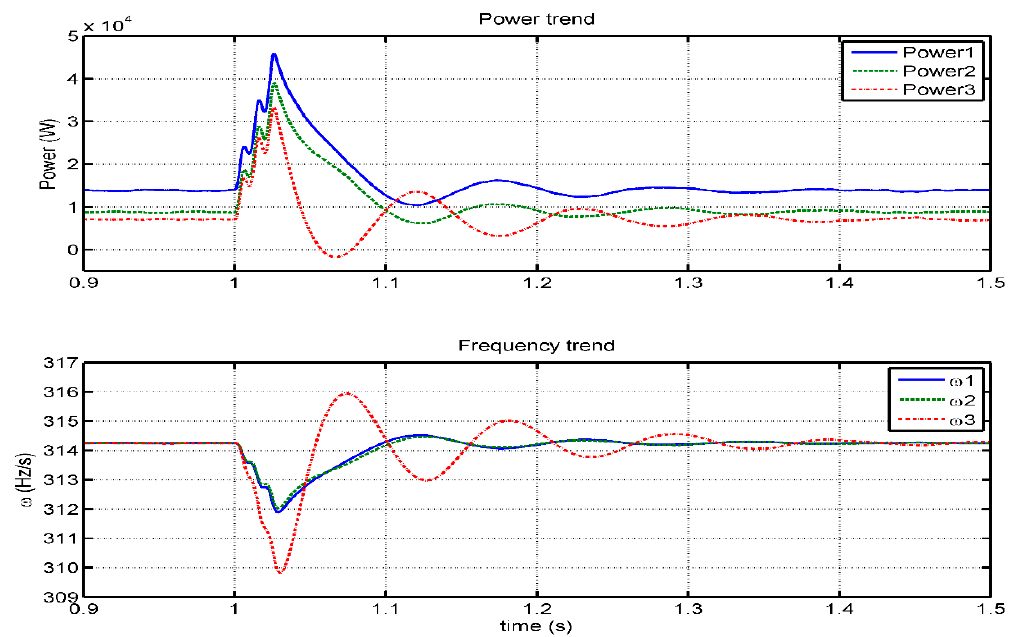
Figure 21. Fault Analysis Case III.